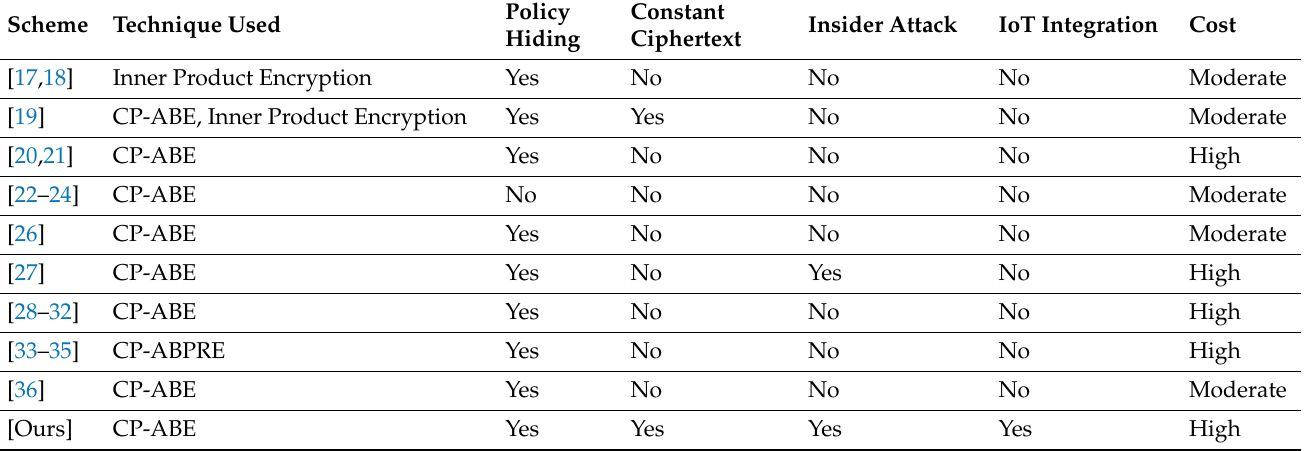
Table 1. Related works comparison with the proposed